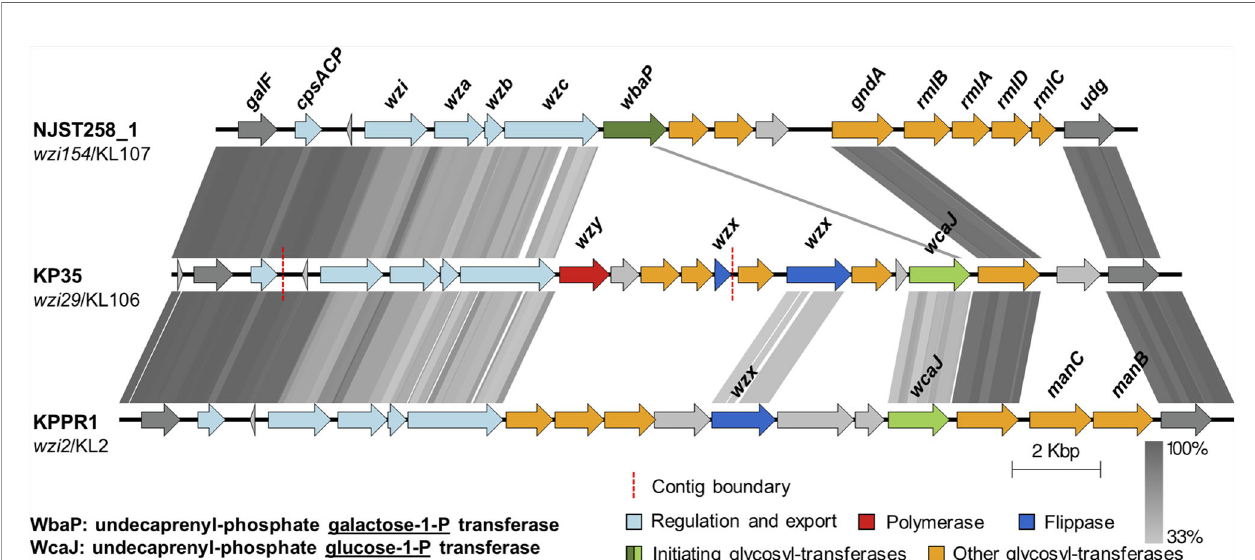
FIGURE 2 | The capsular polysaccharide synthesis ( cps) loci of KP35 and KPPR1 encode the glycosyl-transferase initiator WcaJ. tBLASTx comparisons of the cps loci found in strains NJST258_1, KP35 and KPPR1. Grey lines represent identity at the amino acid level, from 33 to 100%. The wzi allele and capsular type are indicated below each strain name. The regions showed in the fi gure correspond to coordinates: 1793433 to 1814332, for NJST258-1 (NZ_CP006923.1); 274446 to 297347 for the contigs of KP35 (see methods); and 5170058 to 5195339 for KPPR1 (NZ_CP009208.1).